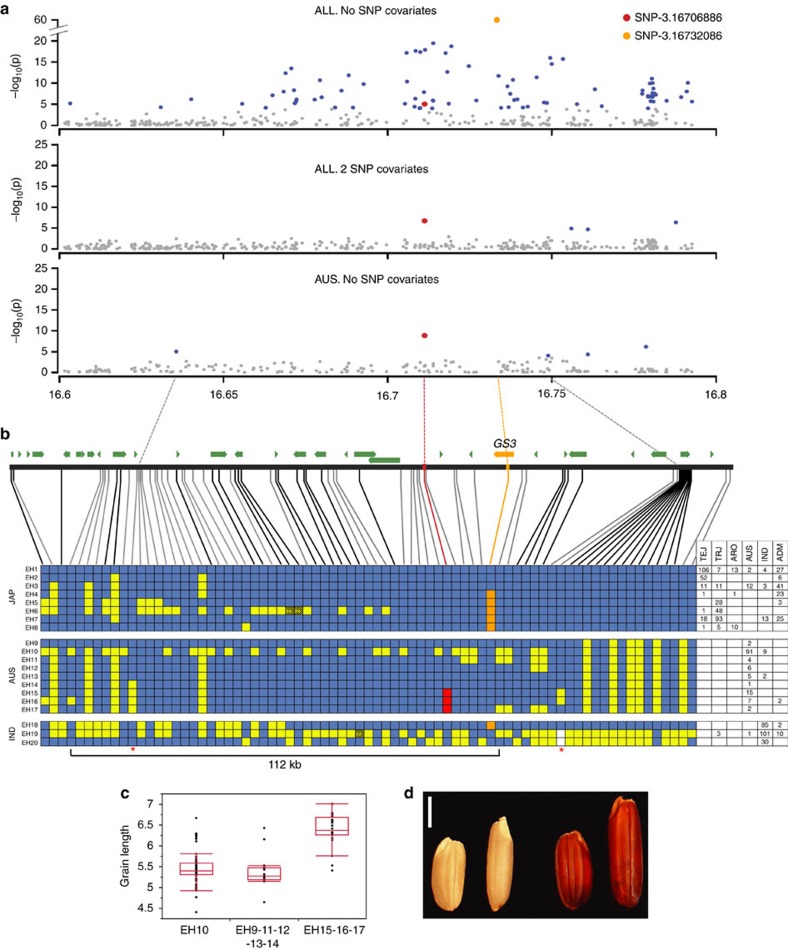
The aus-specific peak on chromosome 3.(a) Zoom-in of chromosome 3 (16.6–16.8 Mb) showing GWAS peaks over GS3 using the HDRA with RDP1 and 2 ALL (top), ALL with 2 SNP covariates (centre), and the aus subpopulation (bottom). The aus MS-SNP (SNP-3.16709886) is indicated by a red circle and the ALL MS-SNP (SNP-3.16732086) by an orange circle. Dashed lines connecting (a,b) indicate the position of the aus MS-SNP (red), the GS3 FNP (orange), and the second and third MS-SNPs in aus (grey). (b) Extended haplotype (EH) analysis across the peak region in RDP1 and 2. Top track shows the position of each SNP used in the analysis, connected by lines to the haplotype table below. Gene models are represented by green arrows; GS3 by an orange arrow. SNPs connected by a grey line are located in intergenic regions; those connected by a black line fall within genes. Rows in the haplotype table correspond to consensus haplotype groups constructed based on HDRA SNP data. Blue cells represent SNPs identical to the Nipponbare reference; yellow cells represent variant alleles; dashed yellow cells represent heterozygotes and white represent missing data. The aus-specific MS-SNP is highlighted in red and the GS3 FNP in orange. The second and third aus MS-SNPs are indicated by red stars under the haplotype table. The number and subpopulation identity of varieties carrying each haplotype are indicated in the table. EHs are represented as a consensus and minor variation is present within each group. For clarity, low-frequency recombinant haplotypes are not displayed (except for those aus recombinant haplotypes informative for the present analysis). (c) Quantile boxplots showing phenotypic distribution (average grain length) for varieties carrying the common aus haplotype, varieties with introgression carrying the reference allele at SNP-3.16709886 (EH9, 11, 12, 13 and 14); and with introgression carrying the derived allele at SNP-3.16709886 (EH15, 16 and 17). The ends of the each box represent the 75th and 25th quantiles (d) Representative aus accessions with short and long grain phenotypes: Left to right: Ghorbhai/NSFTV326 (EH10), Phudugey/NSFTV131 (EH17), Jamir/NSFTV328 (EH12) and PTB-30/NSFTV360 (EH15). Scale bar, 2 mm.